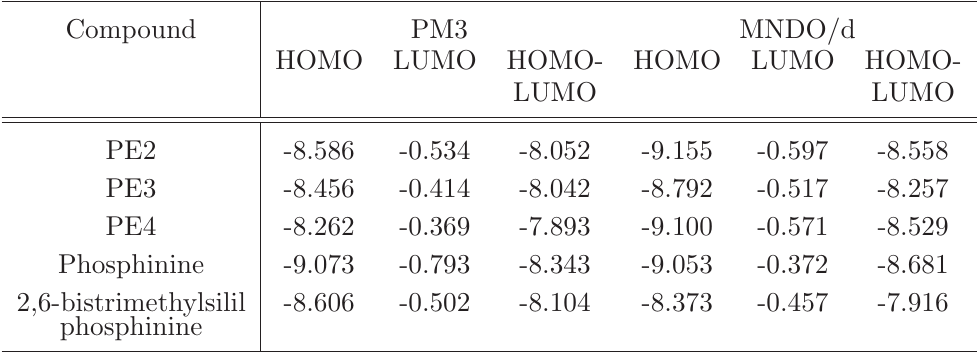
Table 7 HOMO and LUMO energies and HOMO-LUMO gaps calculated with PM3